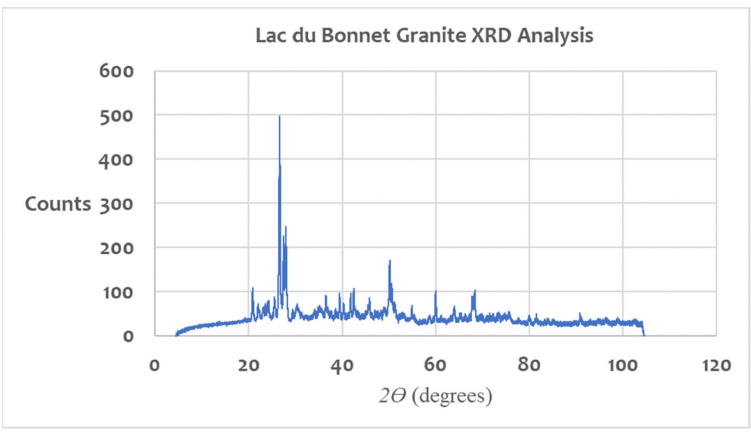
Figure 6. X-ray diffractogram of Lac du Bonnet granite powder.